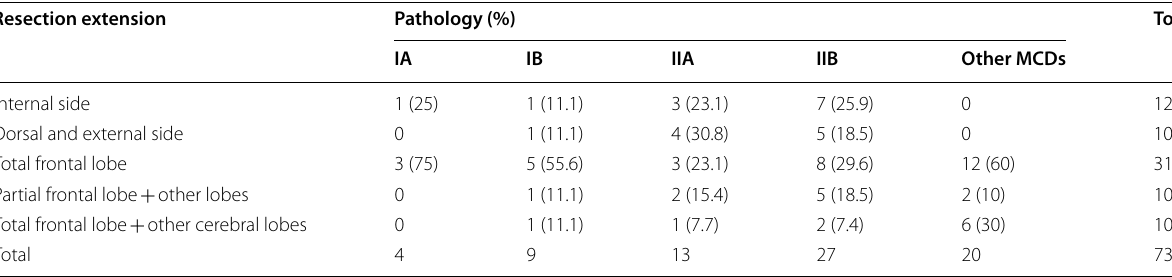
Table 4 Resection extension and pathology